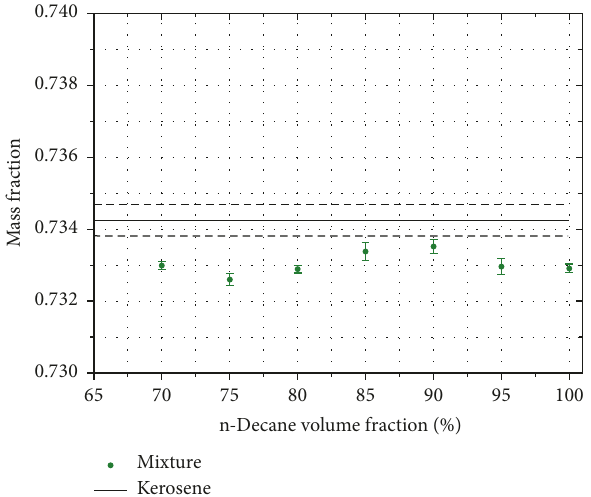
Figure 9: Comparison of mass fraction of N2 for the surrogate and the kerosene burning.